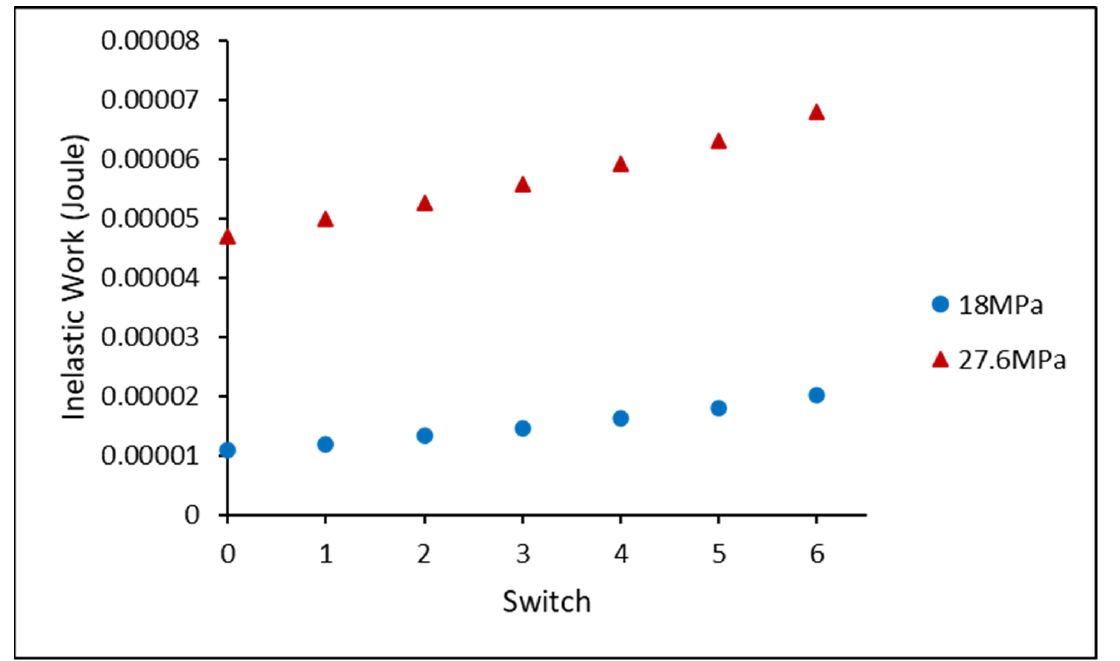
Figure 10. Average inelastic work of non-aged SAC305 individual soler joint in varying stress amplitude test (18–27.6 MPa).